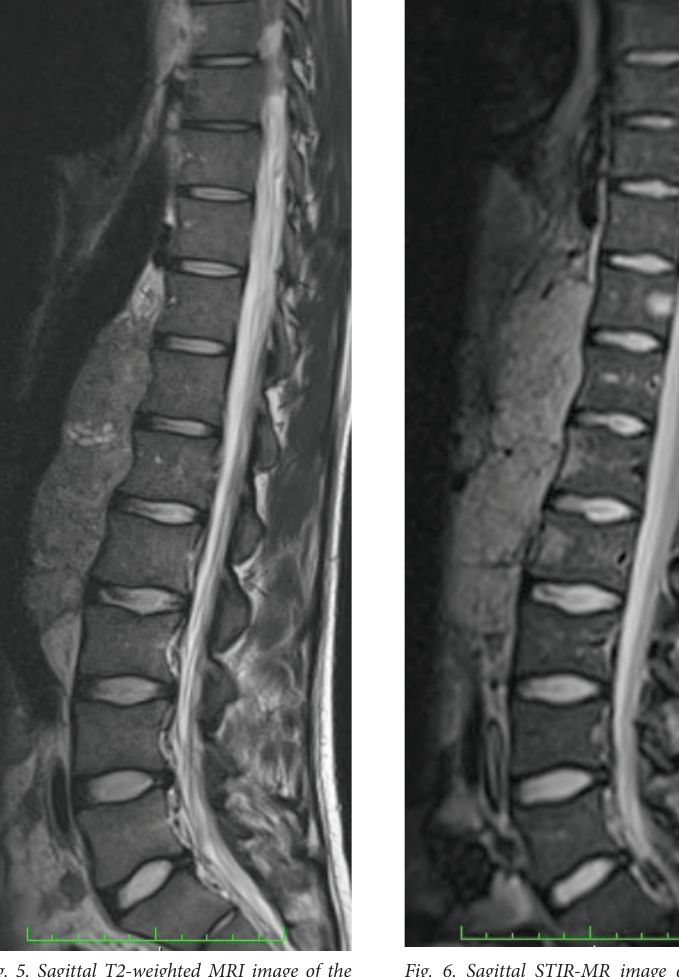
Fig. 5. Sagittal T2-weighted MRI image of the lumbar spine.